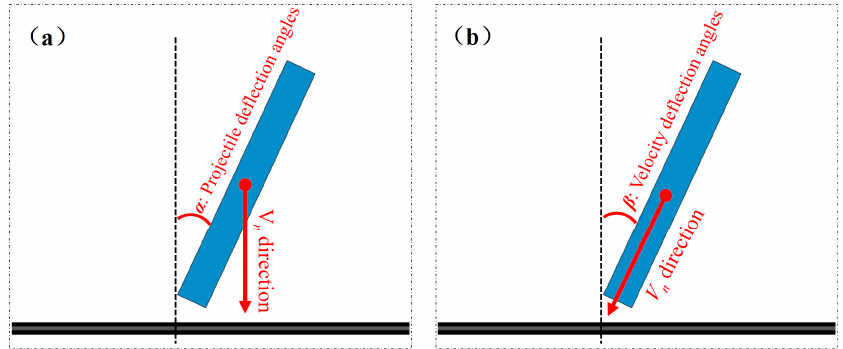
Figure 6. Sketch map of the different impact attitudes at V n , (numerical impact velocity of the projectile), ( a ) projectile deflection angle α , ( b ) velocity deflection angle β .